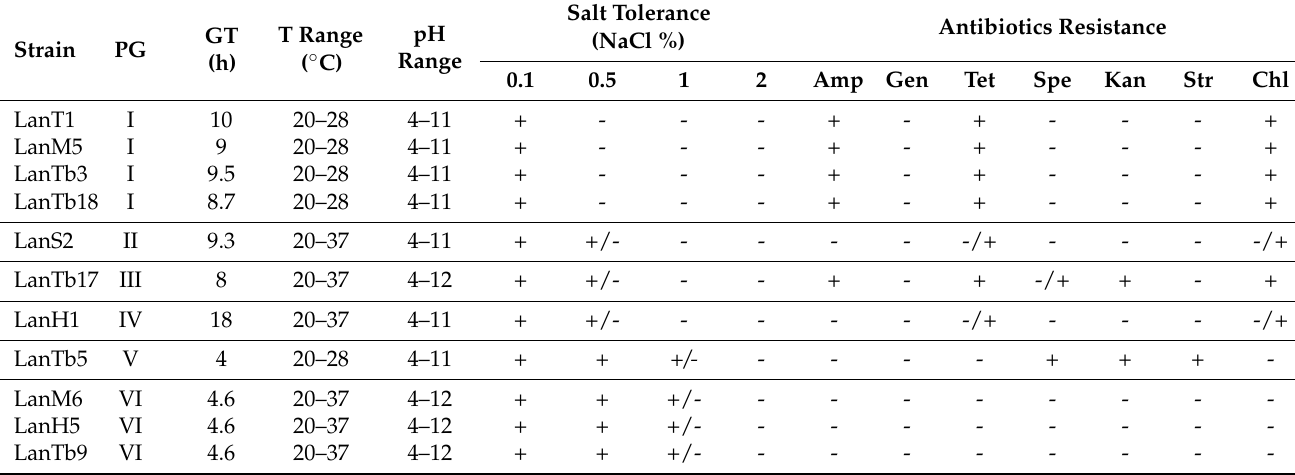
PG: Phylogenetic groups identified in Figure 1. GT: Generation Time-, no growth; +/-, weak growth (10–30% compared to the control in YMA); +, good growth (similar to the control) Amp: ampicillin (100 µ g/mL); Gen: gentamicin (30 µ g/mL); Tet: tetracycline (5 µ g/mL); Spe: spectinomycin (50 µ g/mL); Kan: kanamycin (50 µ g/mL), Str: streptomycin (10 µ g/mL).and Chl: chloramphenicol (10 µ g/mL). Values represent the average of two experiments with three replicates each